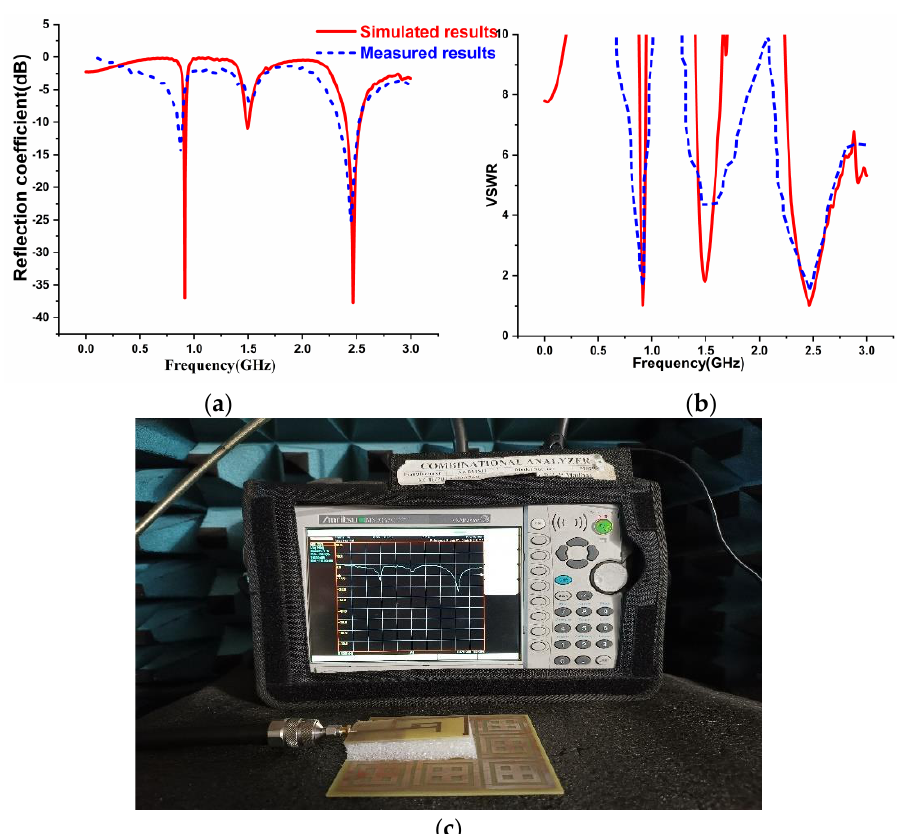
Figure 16. Simulated and Fabricated results of the antenna with AMC Structure ( a ) Reflection Coefficient ( b ) VSWR ( c ) Snapshot of the antenna with AMC Backing Results.